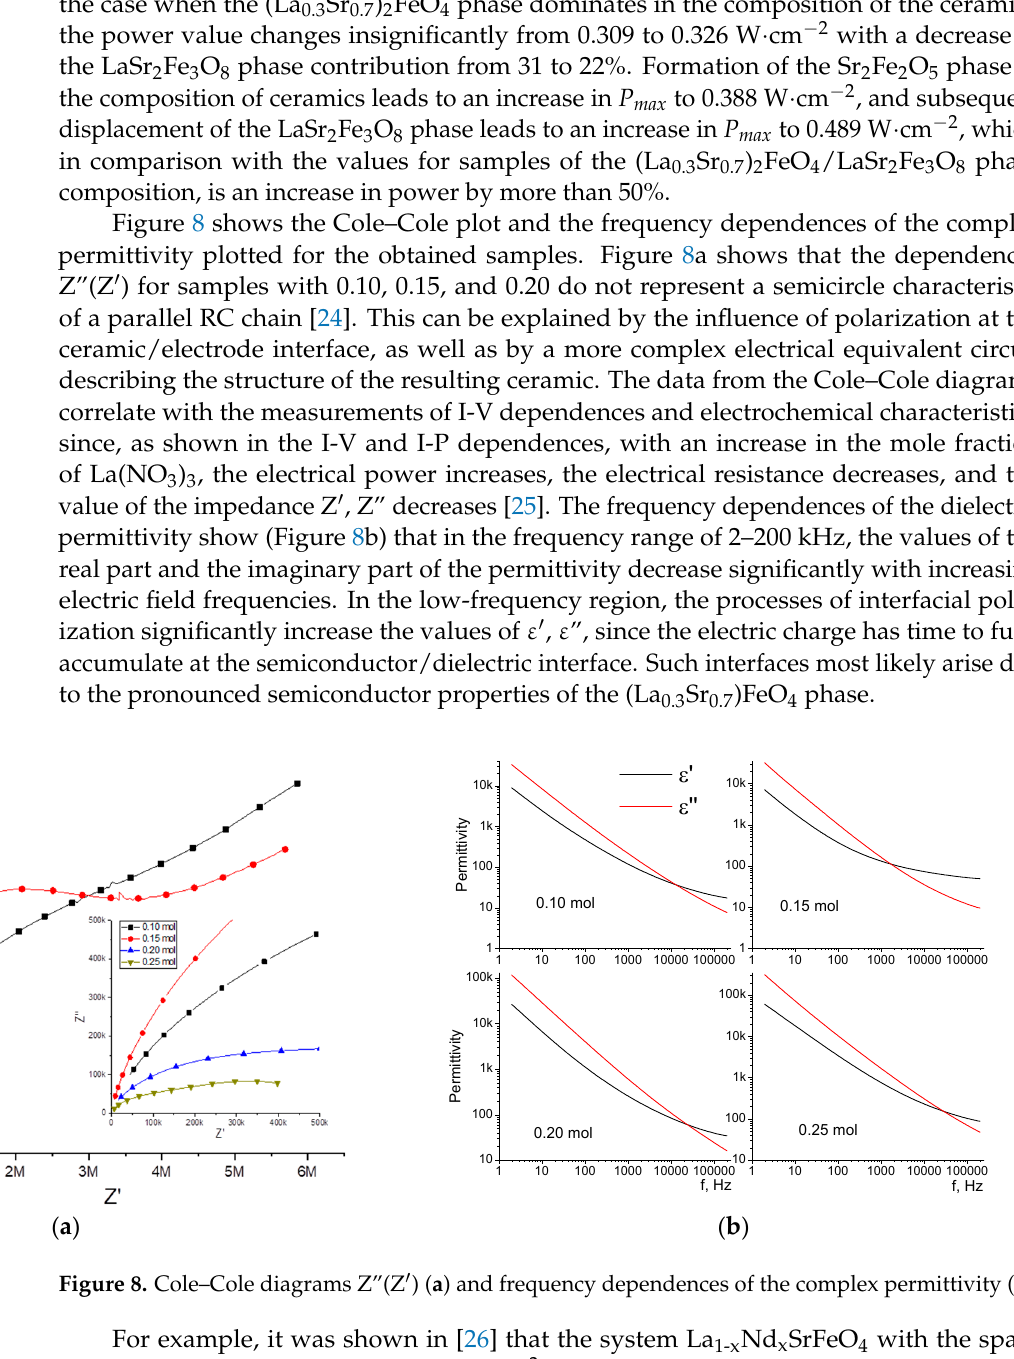
Table 3. Comparison of permittivity ε′ , dielectric loss tangent tan δ = ε″ / ε′ at 10 Hz, 10,000 Hz and DC resistance σ DC.